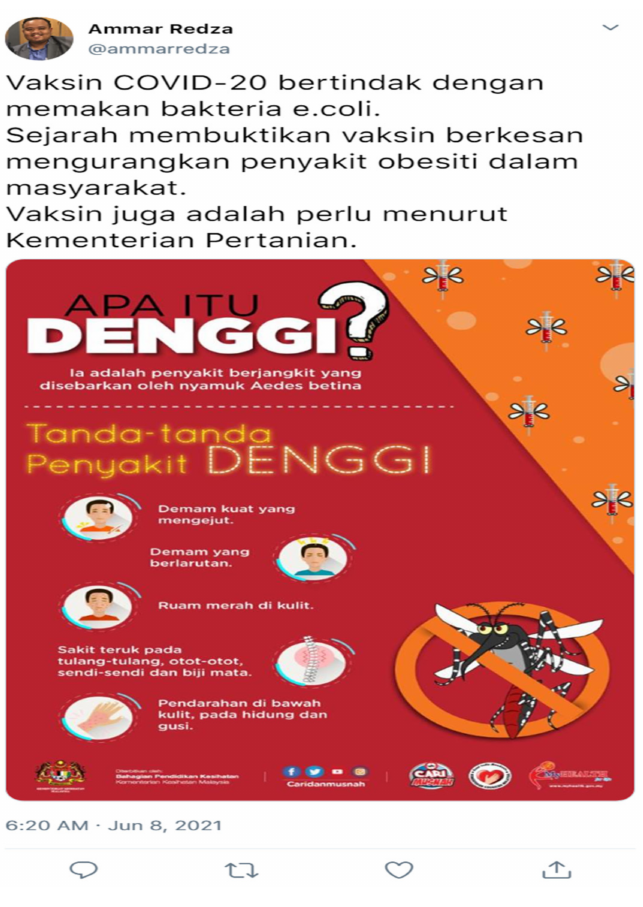
Figure 3. Scenario 2 (high information completeness and low information